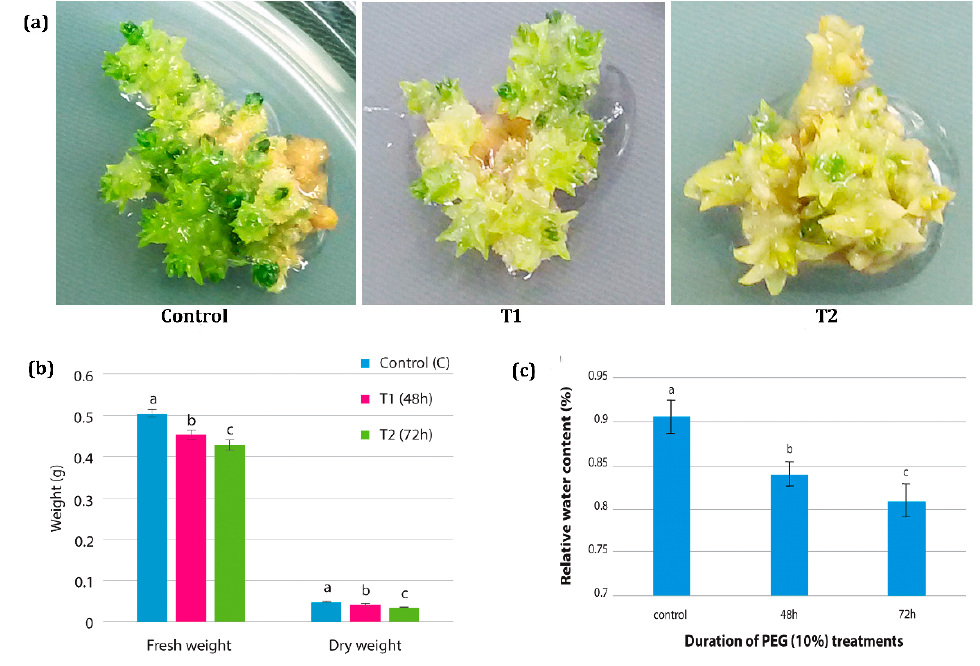
Figure 2. The e ff ect of polyethylene glycol (PEG)-induced drought stress in H. persicum . ( a ) PEG-induced drought on adventitious shoot buds under in vitro conditions. Control: shoot buds at control media (MS without PEG), T1: cultures at 48 h of PEG treatment, T2: cultures at 72 h of PEG treatment. ( b ) The e ff ect of PEG treatment on tissue fresh weight (g) and dry weight (g) in control sample (C), T1 sample (48 h PEG treatment) and T2 sample (72 h PEG treatment). ( c ) The e ff ect of PEG treatment on Relative Water Content (RWC) in control samples, 48 h PEG treated samples and 72 h PEG treated samples. The error bar represents the standard deviation. Bar graph with di ff erent letters indicates significant di ff erence between the mean values ( p ≤ 0.05).